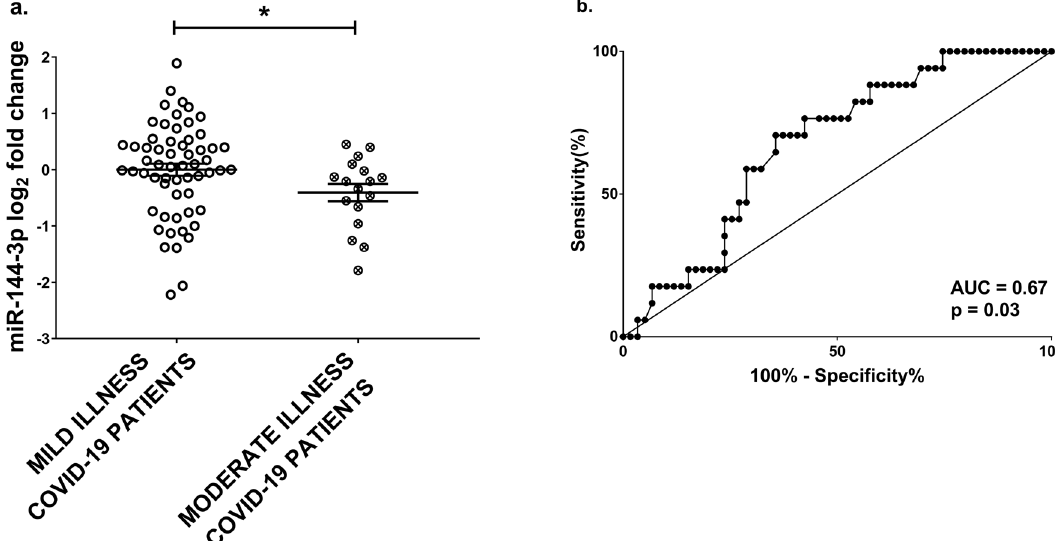
Figure 5. miR-144-3p in mild and moderate COVID-19 non-hospitalized patients recruited at LIH. miR- 144-3p plasma levels were measured by qPCR. Values are expressed as log 2 fold change compared to mild illness patients and shown as dot- plots indicating mean ± SEM. miR-144-3p expression levels are lower in more ill patients. Mann–Whitney test (two groups) was performed for statistical comparison ( a ). The ROC curve shows the sensitivity and specificity of miR-144-3p to distinguish mild from moderate COVID-19 patients ( b ). Mild illness patients n = 59; moderate illness patients n = 17; * p <